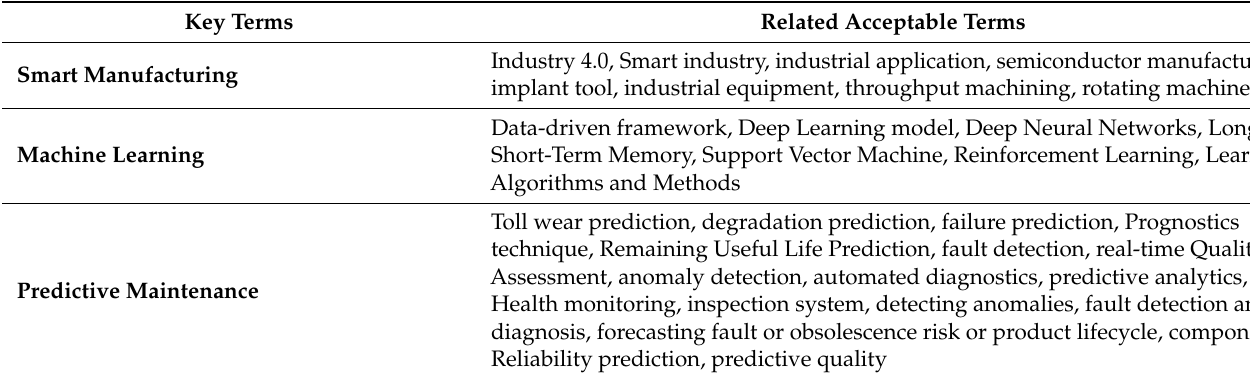
Table 1. Main database for research criteria.